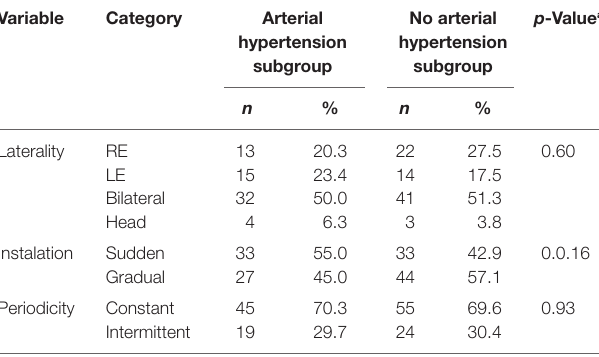
Table 6 | analysis of the categorical variables (tinnitus clinical characteristics) according to the tinnitus’ patients’ subgroups (with and without arterial hypertension).